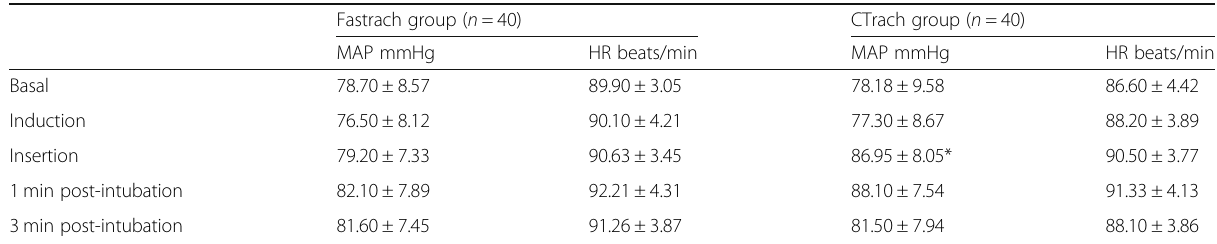
Table 4 Hemodynamic variations during tracheal intubation in both groups. Values are mean